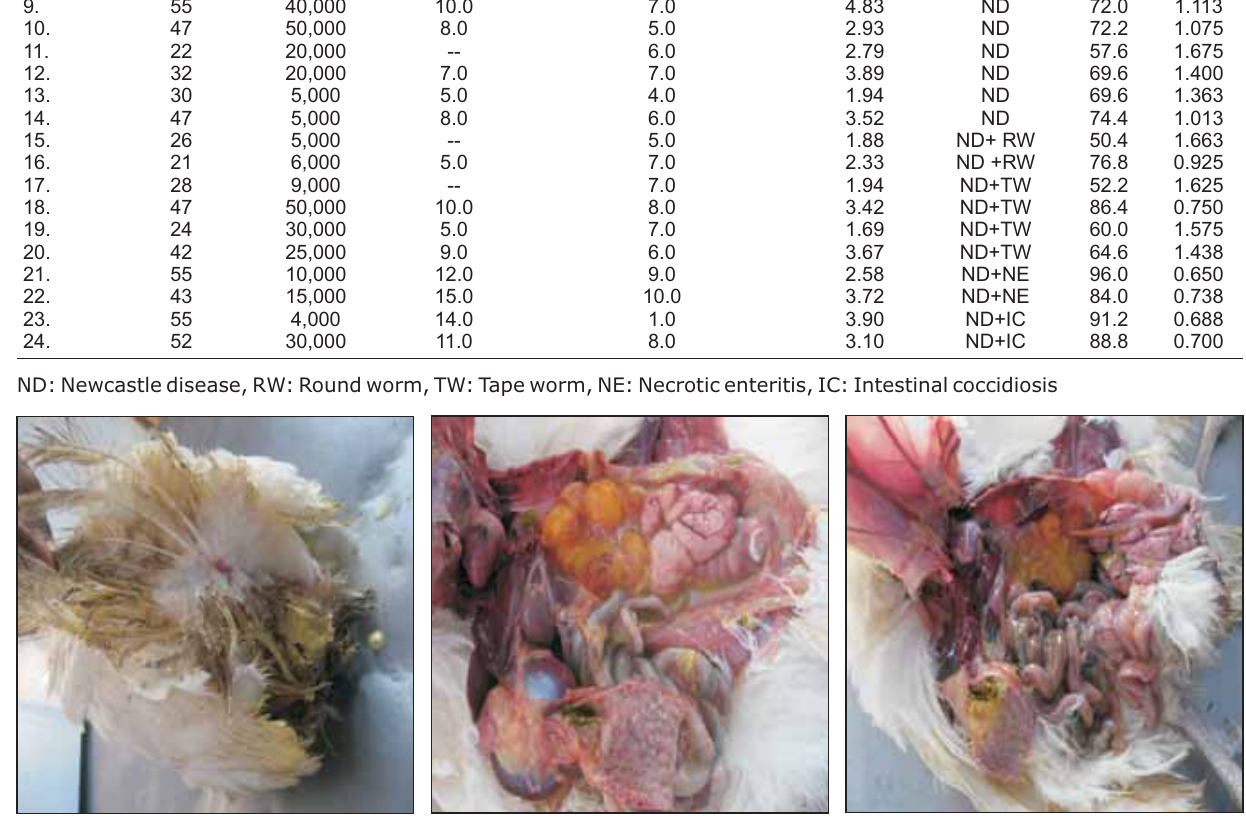
Figure-2: ND : Petechial haemorrhages in the proventriculus with haemorrhagic and degenerated ovarian follicles.